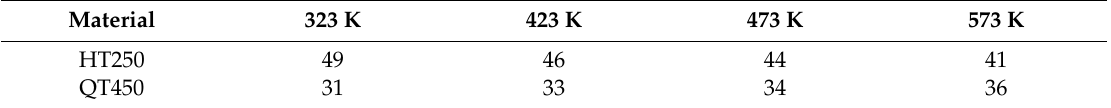
Table 5. Thermal conductivity at a di ff erent temperature, W / (m · K).